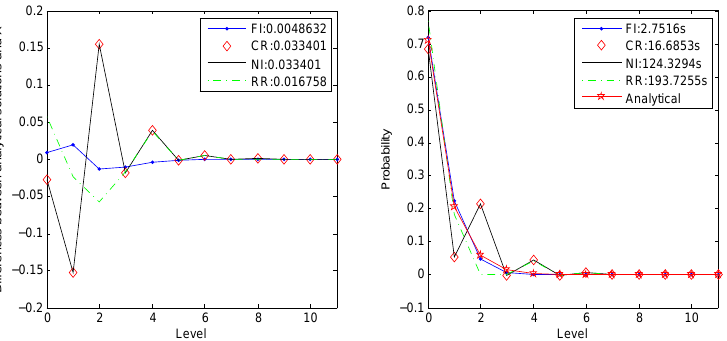
Figure 7. Difference among methods on level marginal invariant probability distribution L Π k .